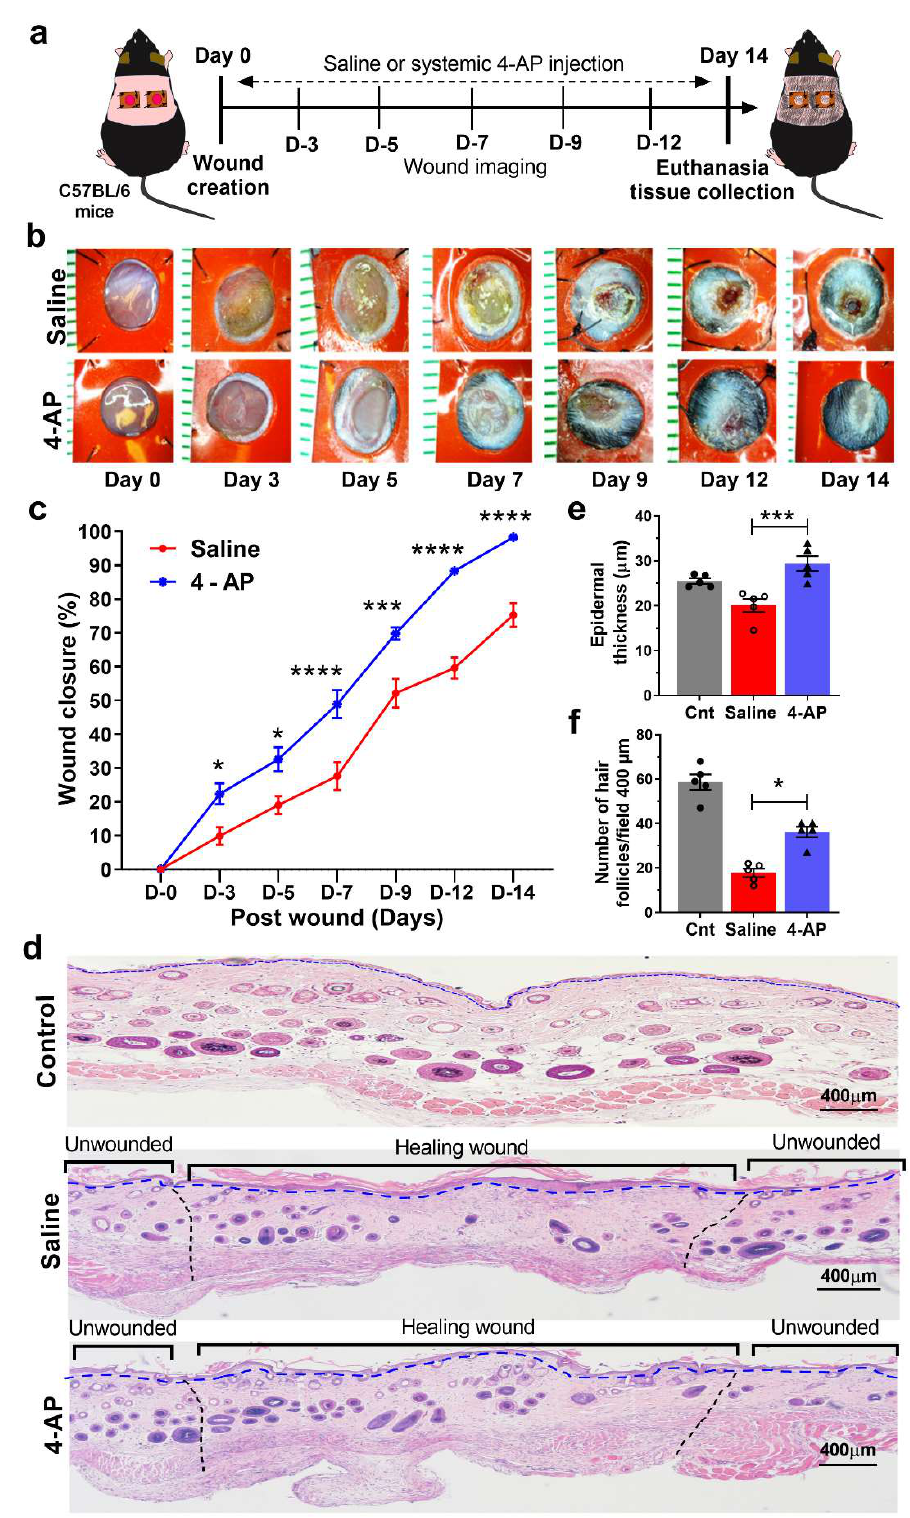
Figure 1. 4-aminopyridine (4-AP) expedites wound closure and enhances skin regeneration. ( a ) Schematic illustration of experimental design to test the beneficial therapeutic effect of 4-AP in the C57BL/6 mouse splinted wound model. ( b ) Representative images of wound healing in control (saline-treated) and 4-AP treated mice at 0, 3, 5, 7, 9, 12, and 14 days post wounding (PWD). Scale bar, 1 mm. ( c ) Percent wound healing at each time point relative to the initial wound area in control and 4-AP-treated mice. Value represents mean ± SEM, n = 5 animals per group, with 2 wounds per